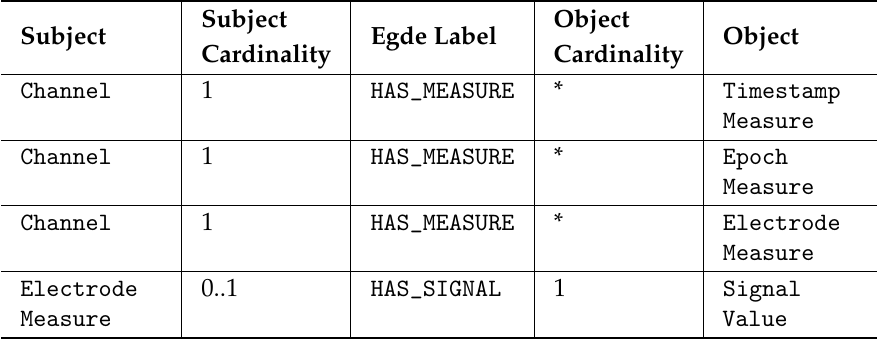
Table A5. Cardinality and endpoint